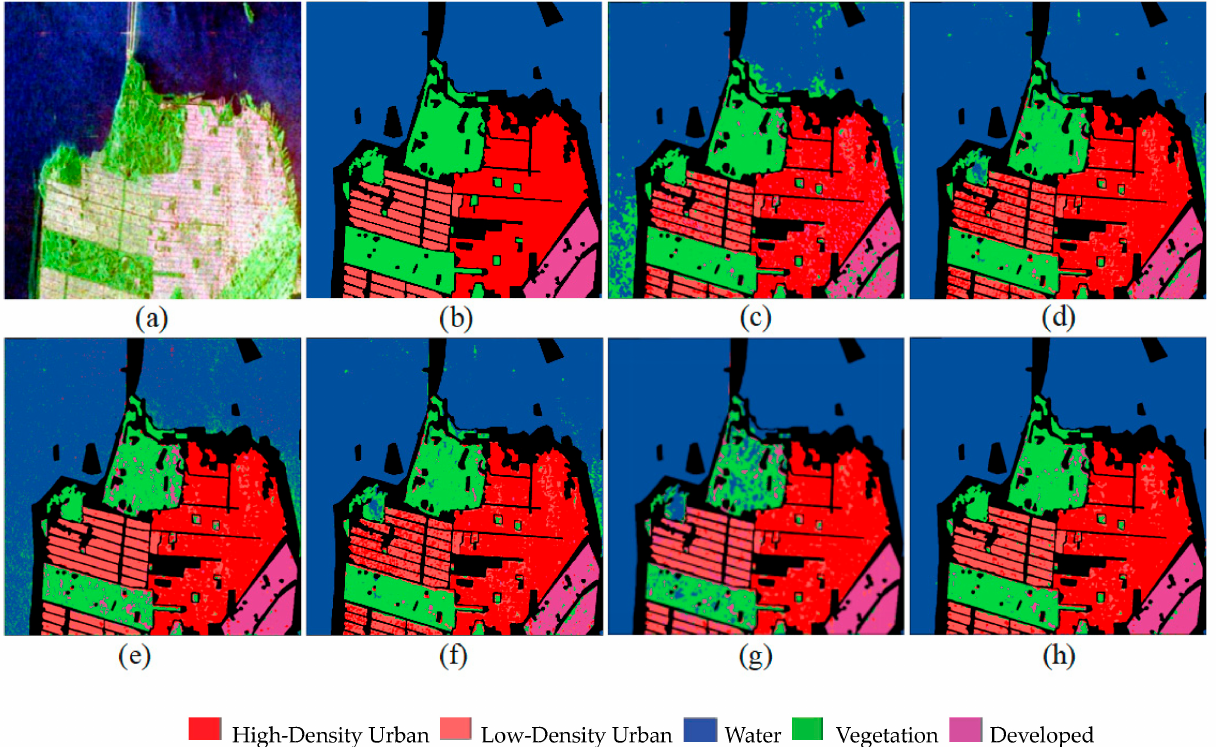
Figure 14. Classification results of the San Francisco dataset. ( a ) Pauli image. ( b ) Ground-truth image.